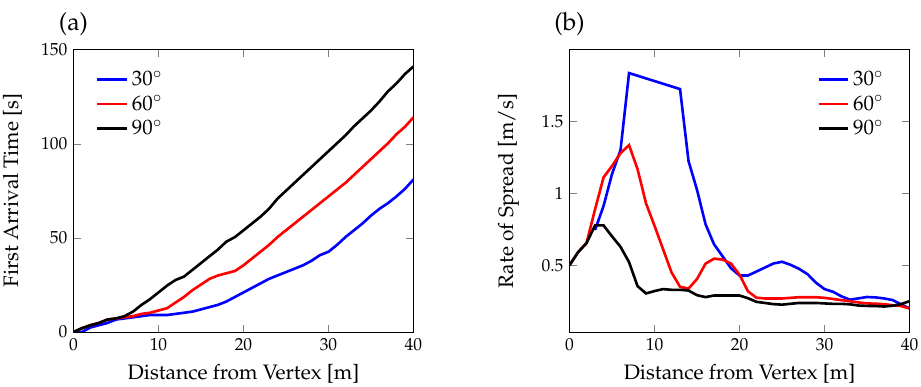
Figure 7. The first arrival time, in seconds, of a junction fire with three different opening angles. In all examples, the background wind is U BG = 4 m/s, U sink = 3.63 × 10 − 2 , U vort = 0, and the burn time is τ b = 15 s.